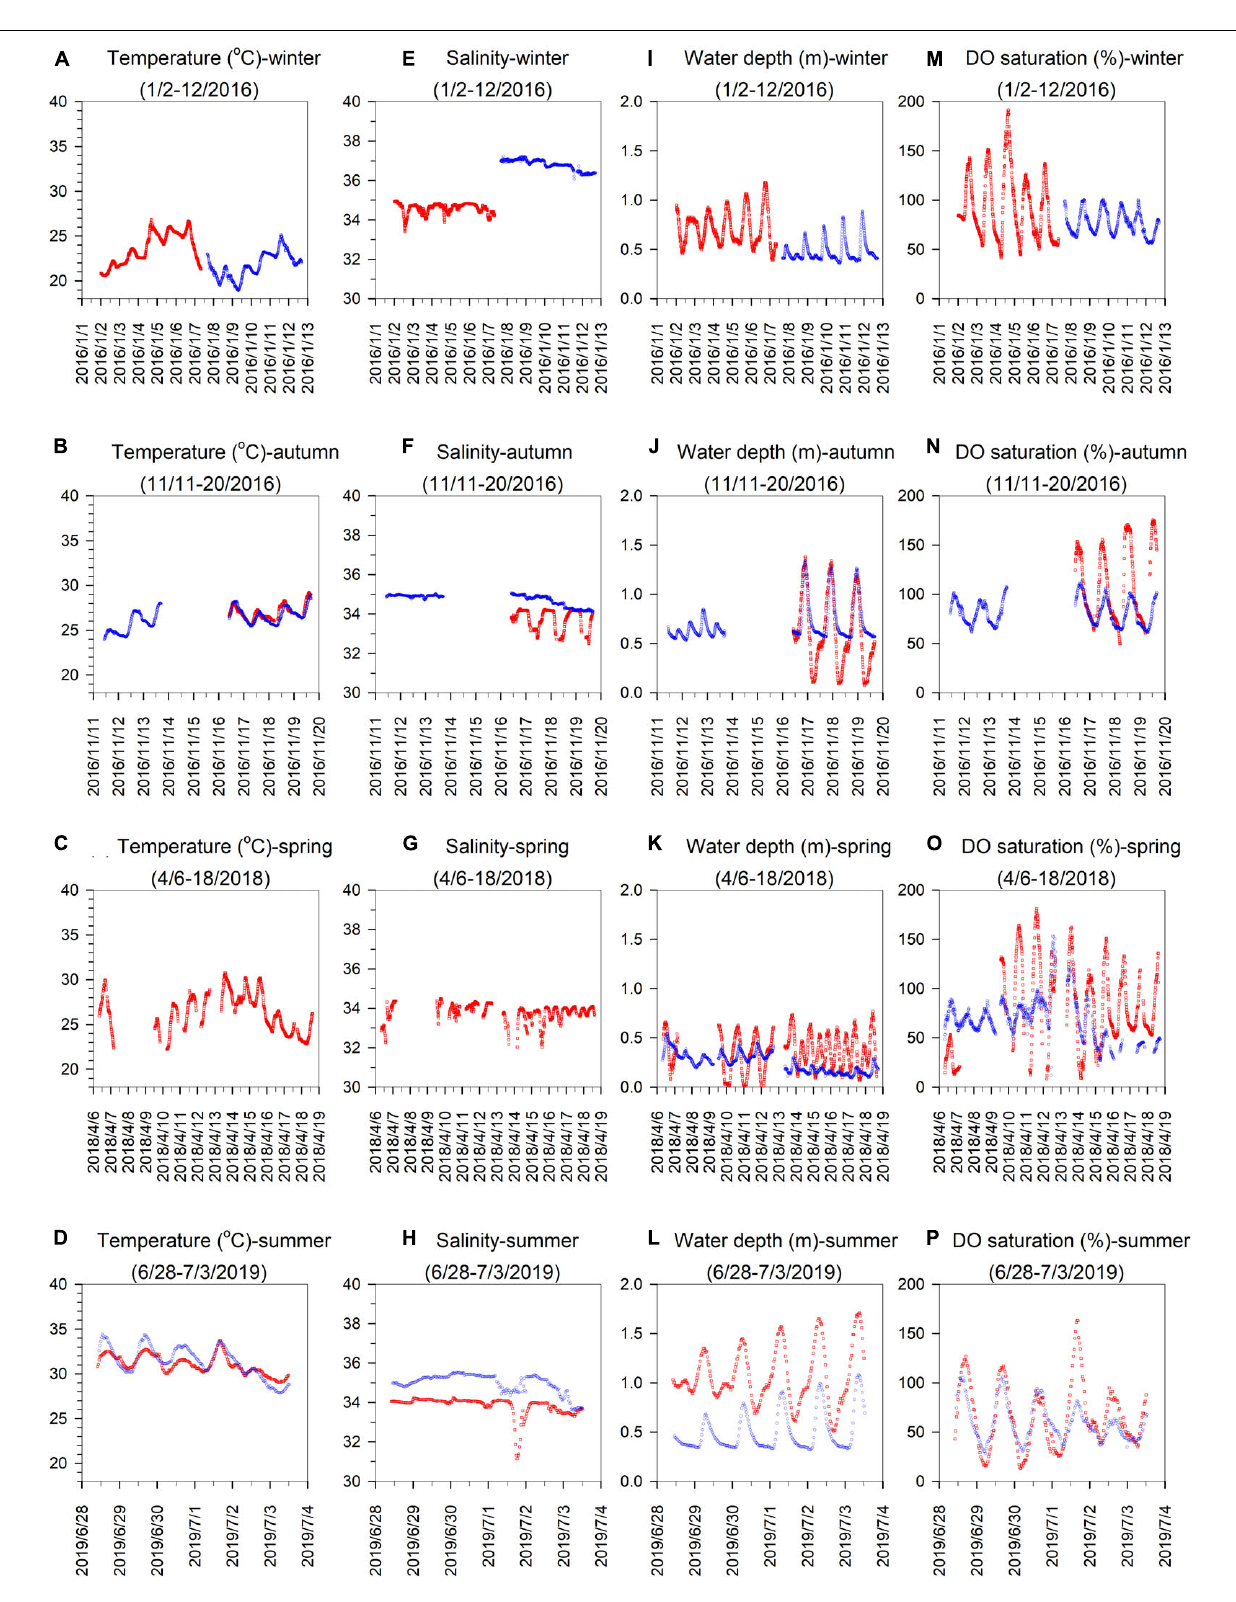
Frontiers in Marine Science |